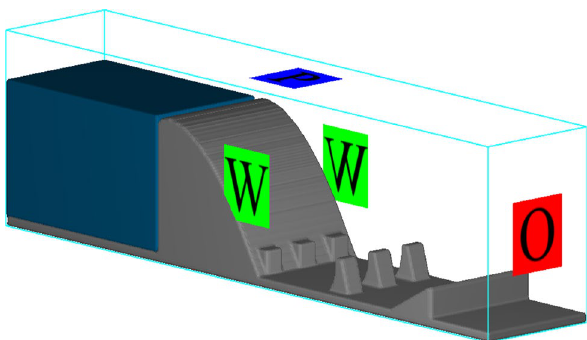
Fig. 11 Solid model used in the CFD simulations of single-row trap- ezoidal energy dissipaters. a Numerical model solution in the CFD simulations of single circular energy dissipaters and calculated Froude numbers. b Numerical model solution in the CFD simulations of single circular energy dissipaters and calculated